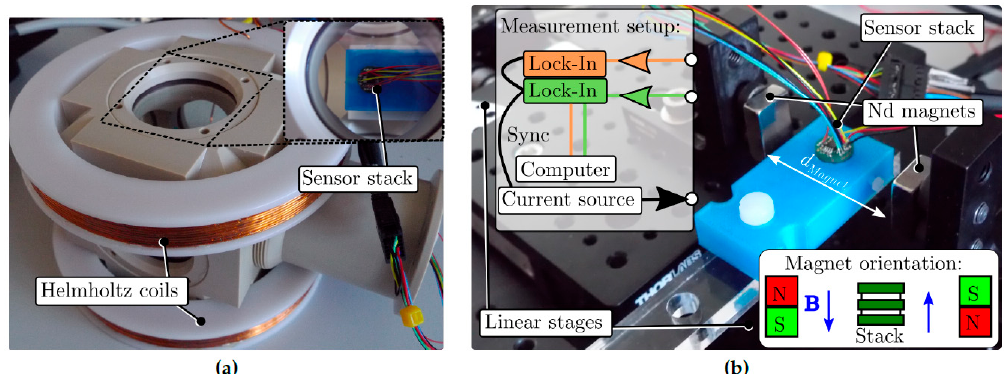
Figure 2. ( a ) Helmholtz configuration to characterise the sensor within a homogeneous magnetic field. ( b ) Measurement setup to realise a magnetic gradient field. The sensor stack is centered between two neodymium magnets which are fixed onto linear stages. The distance between the magnets d Magnet and the sensor stack is gradually changed to generate different | ∇ B |.